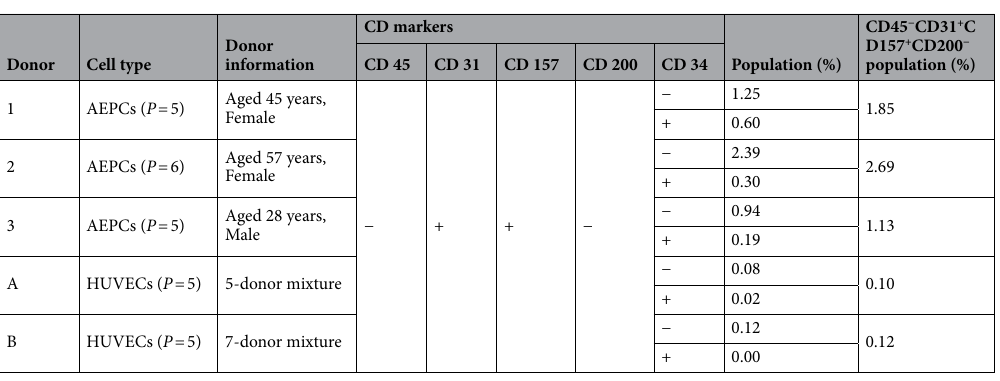
Figure 5. Characterization and functional analysis of expanded AEPCs compared with HUVECs. All the experiments were performed using AEPCs and HUVECs at passage number 5. ( A ) Fluorescent immunocytochemistry of the expression profiles of endothelial cell-specific markers, CD31, vWF, and the binding capacity of isolectin-B4, in AEPCs and HUVECs. Nuclear staining was assessed by 4 ′ ,6-diamidino- 2-phenylindole (DAPI). Photographs were taken using a confocal microscope (OLYMPUS, FV1000 with a CCD camera DP71 and an objective lens UPlanFL N 40×/1.30 oil; 400× magnification) as a plane image. Bars represent 100 µm. The graphs show the percentage of endothelial marker-positive cells among DAPI-positive cells. The data represent two independent experiments (2 donors), and percentages were determined from cultivations performed in triplicate. The bars represent means ± SD (n = 6, ** P < 0.01, two-tailed unpaired t-test). ( B ) CFU-EC analysis of AEPCs and HUVECs. Cells were seeded at 125 cells per 35-mm-diameter well (12.6 cells/cm 2 ) and cultured for 7 days. Each experiment was performed twice independently (two donors) in technical triplicates. The bars represent means ± SD (n = 3; n.s., not significant by two-tailed unpaired t-test). ( C ) Network formation capacity of AEPCs compared with that of HUVECs. Representative phase- contrast pictures corresponding to the right-hand side of the extracted network skeleton. The total segment length (magenta color), total branch length (yellow–green color), and total length were determined using the Angiogenesis Analyzer plugin for ImageJ software. Scale bars represent 100 µm. The experiment was performed independently three times (3 donors) in technical pentaplicates. Bars represent means ± SD (n = 5, ** P < 0.01;